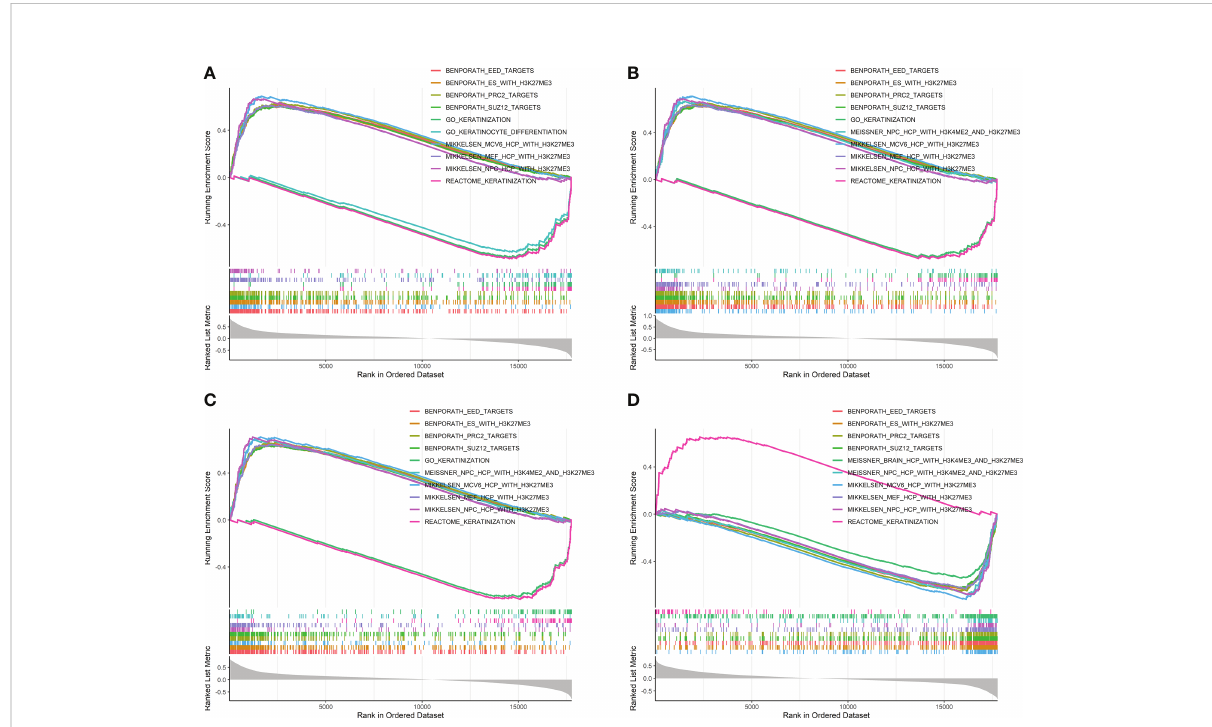
FIGURE 7 Single-gene GSEA results based on the correlation coef fi cients between the methylation levels of the four iRFE MDGs and those of other genes in the TCGA-COAD dataset. The gene sets with the top 10 NES values are shown. (A) ADHFE1 . (B) CNRIP1 . (C) MAFB . (D) TNS4 . NES, normalized enrichment score; GSEA, Gene Set Enrichment Analysis; iRFE, iterative recursive feature elimination; MDGs, methylation-driven